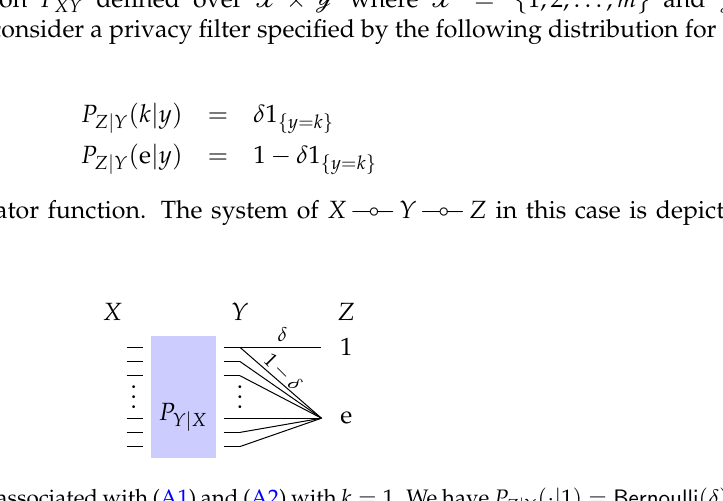
Figure 6. The privacy filter associated with (A1) and (A2) with k = 1. We have P Z | Y ( ·| 1 ) = Bernoulli ( δ ) and P Z | Y ( ·| y ) = Bernoulli ( 0 ) for y ∈ { 2,3, . . . , n }